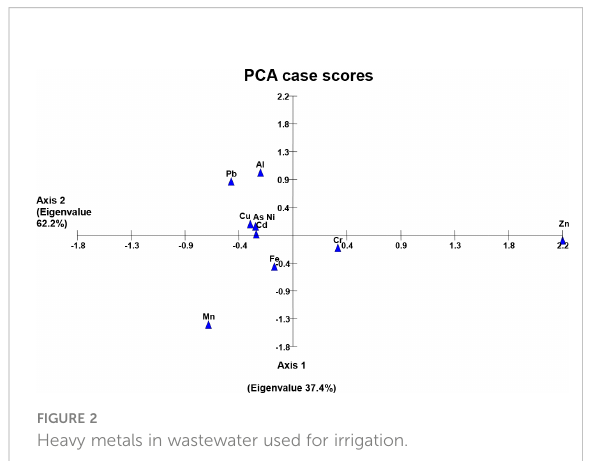
FIGURE 2 Heavy metals in wastewater used for irrigation.